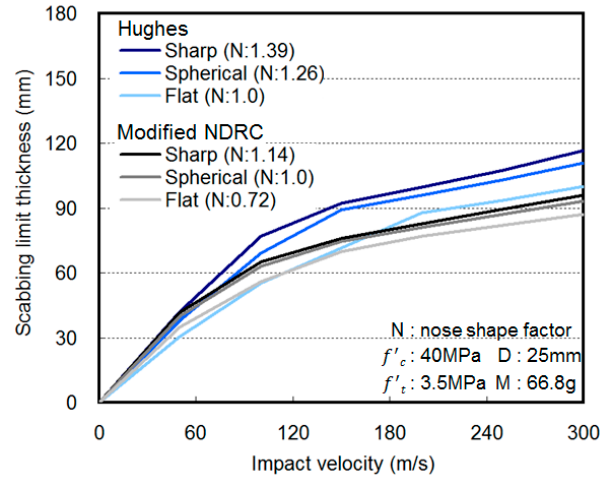
Figure 2. Scabbing limit thickness by projectile nose shape.